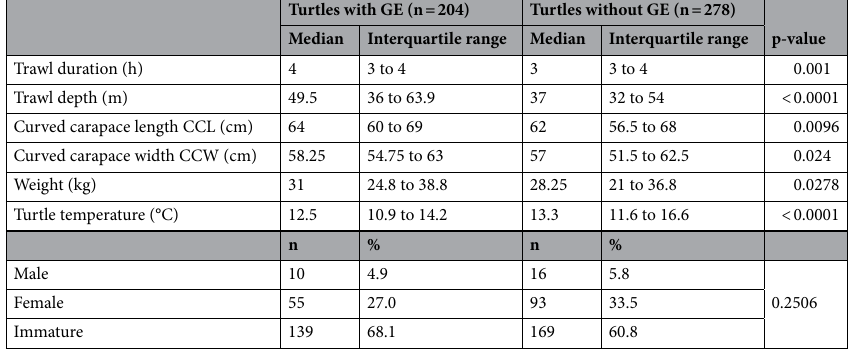
Table 1. Comparison of fishing and clinical data between loggerhead turtles that were accidentally captured during trawling that developed GE (n = 204) and those that did not develop GE (n = 278). Parameters with p < 0.05 were significantly different between the two groups.